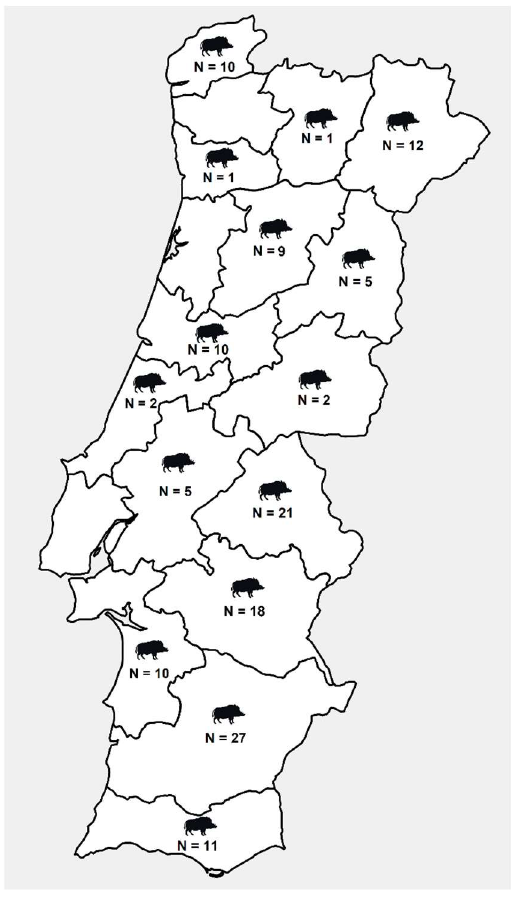
Figure 1. Geographical distribution of wild boar samples in Portugal.